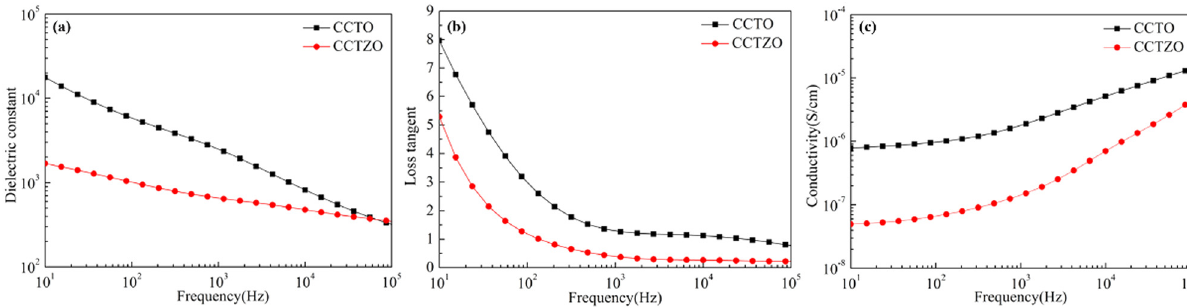
Figure 3: Dependence of ( a ) dielectric constant, ( b ) loss tangent, and ( c ) conductivity of the CCTO and CCTZO particles on